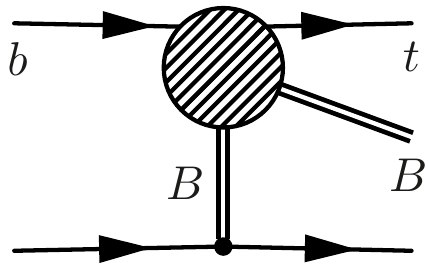
Figure 1. Schematic Feynman diagram for the embedding of an EW top scattering amplitude into a physical, single-top process at a hadron collider. Here f and f 0 must be a b - and t -quark respectively, while B and B 0 can be several combinations of Z; (cid:13); W and h